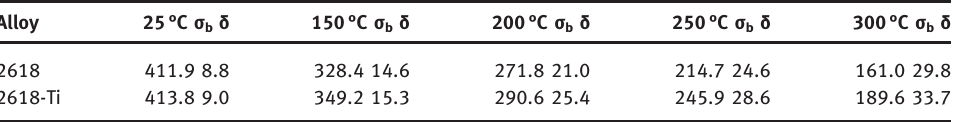
Table 3: Mechanical properties of alloy 2618 and 2618-Ti at different temperatures. Alloy